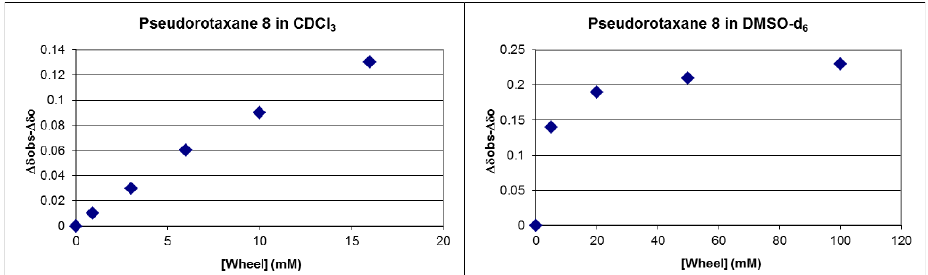
Figure 2. Changes in the chemical shift of an amide proton of pseudorotaxane 8 held at a constant concentration in CDCl 3 and DMSO- d 6 (10 mM and 30 mM, respectively) caused by the increasing concentration of the wheel.